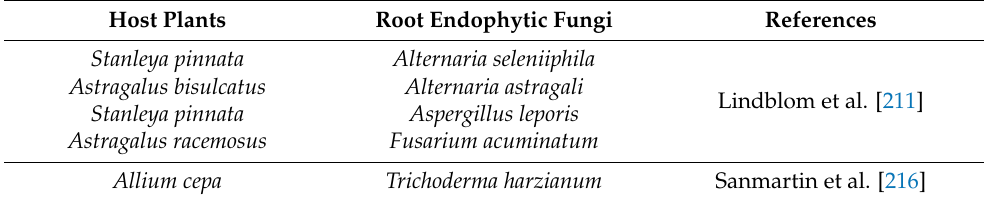
Table 6. Root endophytic fungi used in Se